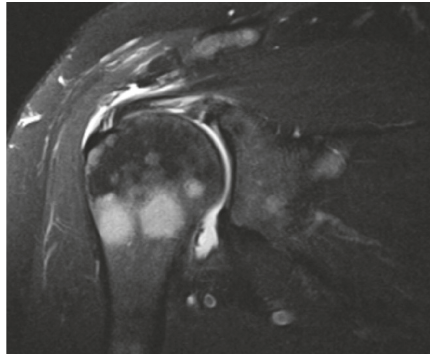
Figure 2: MRI demonstrating sarcoid lesions of the